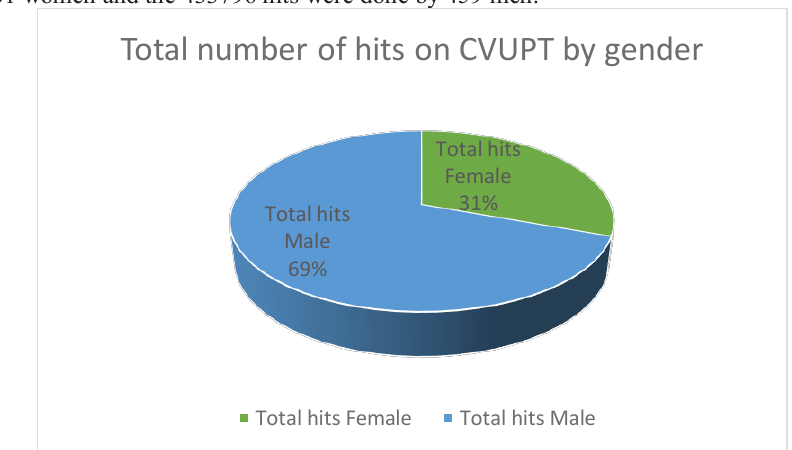
Fig. 2: Total number of hits on the CVUPT platform, according to gender The situation is similar in the case of those who haven’t scored any hit (no actions) on the Virtual Campus, with 2 out of 201 women and 5 out of 459 men. As percentages, these numbers represent 28.57% women users and 71.43% men